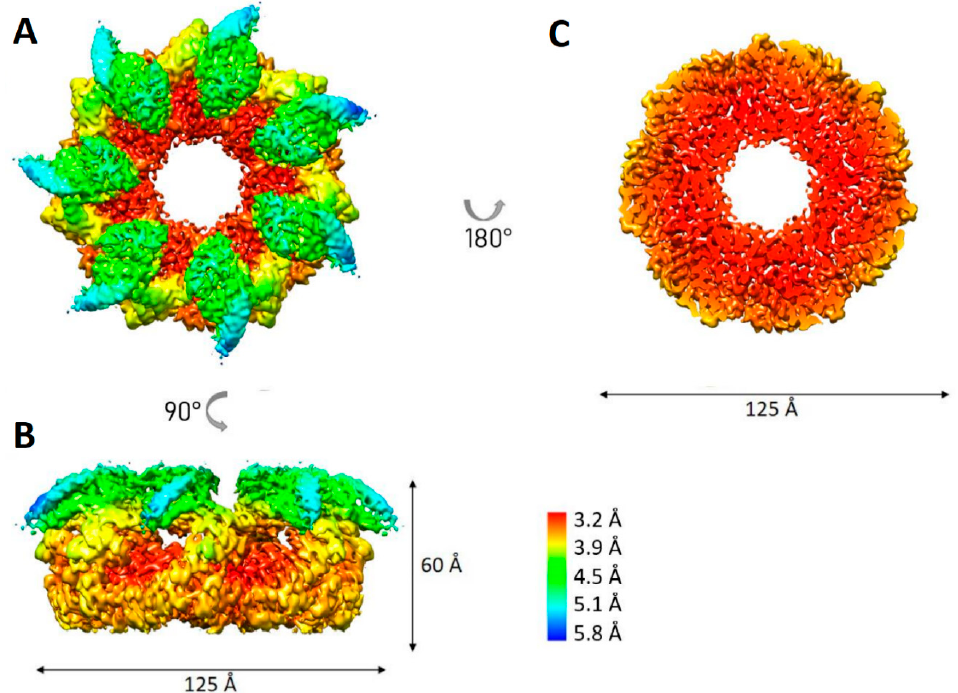
Figure 2. Local resolution estimation for C7 symmetric density map of AR9 chaperonin. ( A ) Top view; ( B ) side view; ( C ) slice through the equatorial domains.